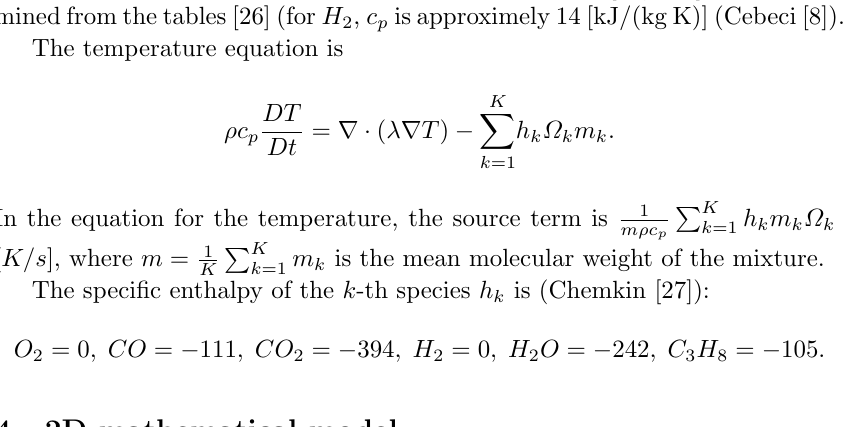
periodic table: O 2 = 32 , CO = 28 , CO 2 = 44 , H 2 = 2 , H 2 O = 18 , C 3 H 8 = 44 . In the equation for the mass fractions of the concentration C k the source term is m k Ω k /ρ